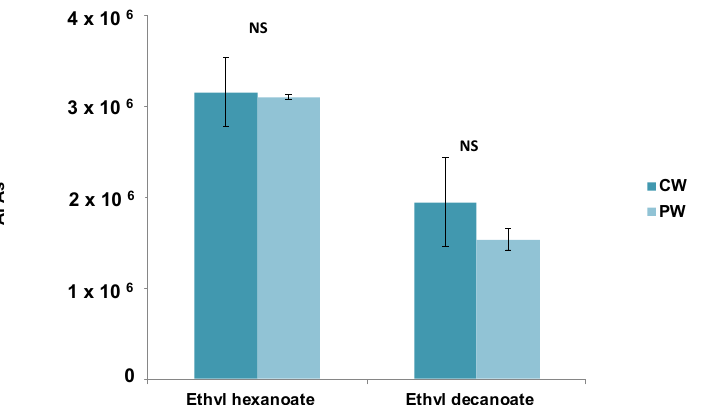
Figure 1. Comparison of the absolute peak areas (APAs) of esters released to the headspace in the control wine (CW) and in the wine with grape seed tannin extract (GSE) added (PW) using in vitro conditions (NS: no significant differences ( p > 0.05) between wine samples).